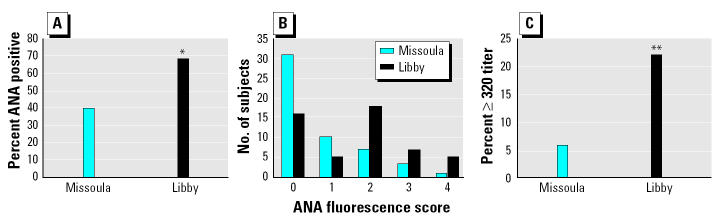
Comparison of ANA in Libby samples with the Missoula samples. (A) Positive and negative tests determined based on known controls provided with the kits (*p = 0.004, Fisher’s exact test; n = 50). (B) ANA fluorescence intensity score based on known controls (p = 0.004, Pearson chi-square test). (C) Percentage in each group with a titer > 320 (**p < 0.01, Fisher’s exact test; n = 50). ANA tests were performed as described in “Materials and Methods.” Groups were screened at a serum dilution of 1:40 and read by two readers; positive tests were then titered to 1:1,280.